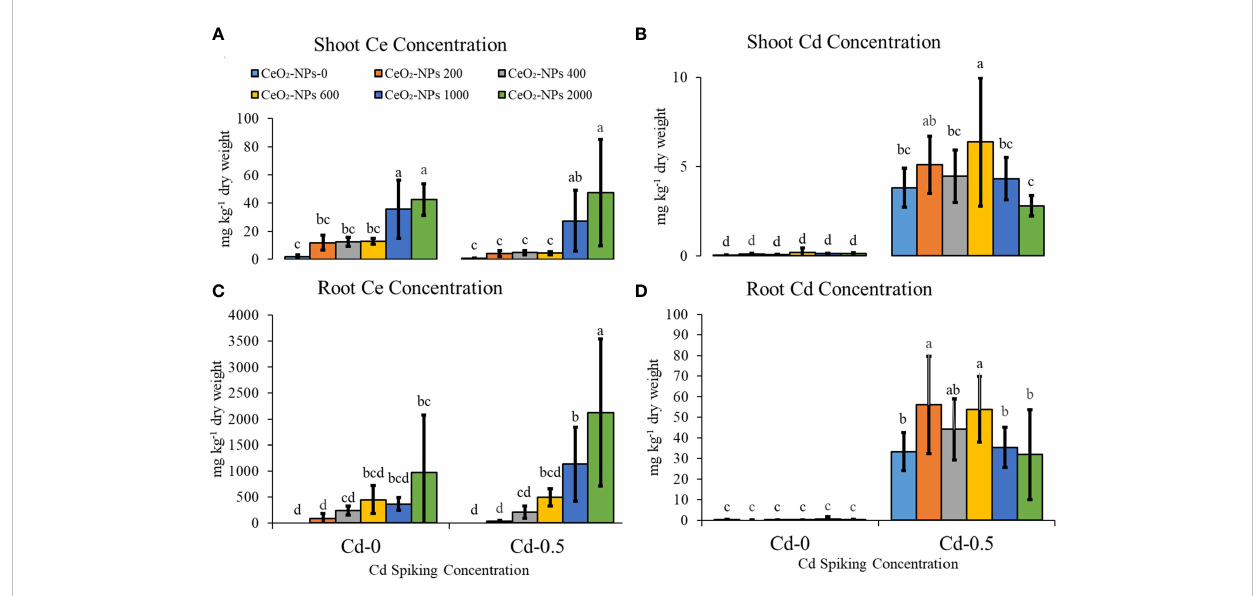
FIGURE 4 Effect of CeO 2 ,-NPs applied at 200, 400, 600, 1000 and 2000 mg kg -1 dry sand alone and in combination with 0.5 mg kg -1 Cd on maize Cd and Ce contents. (A) shoot ce (mg kg dry weight), (B) root ce (mg kg -1 dry weight), (C) shoot cd (mg kg -1 dry weight), (D) root cd (mg kg -1 dry weight). The graphs are of mean ( n = 4) ± standard deviation. Letters shown pair wise comparison via Least Signi fi cant Difference (LSD) at p ≤